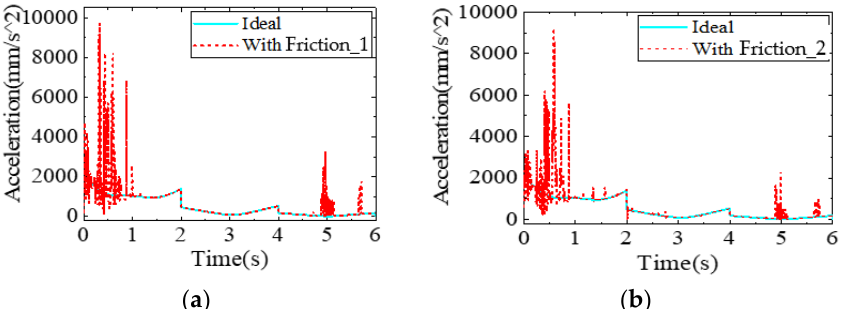
Figure 12. The end acceleration change curve when considering friction. ( a ) With Fraction_1. ( b ) With Fraction_2.